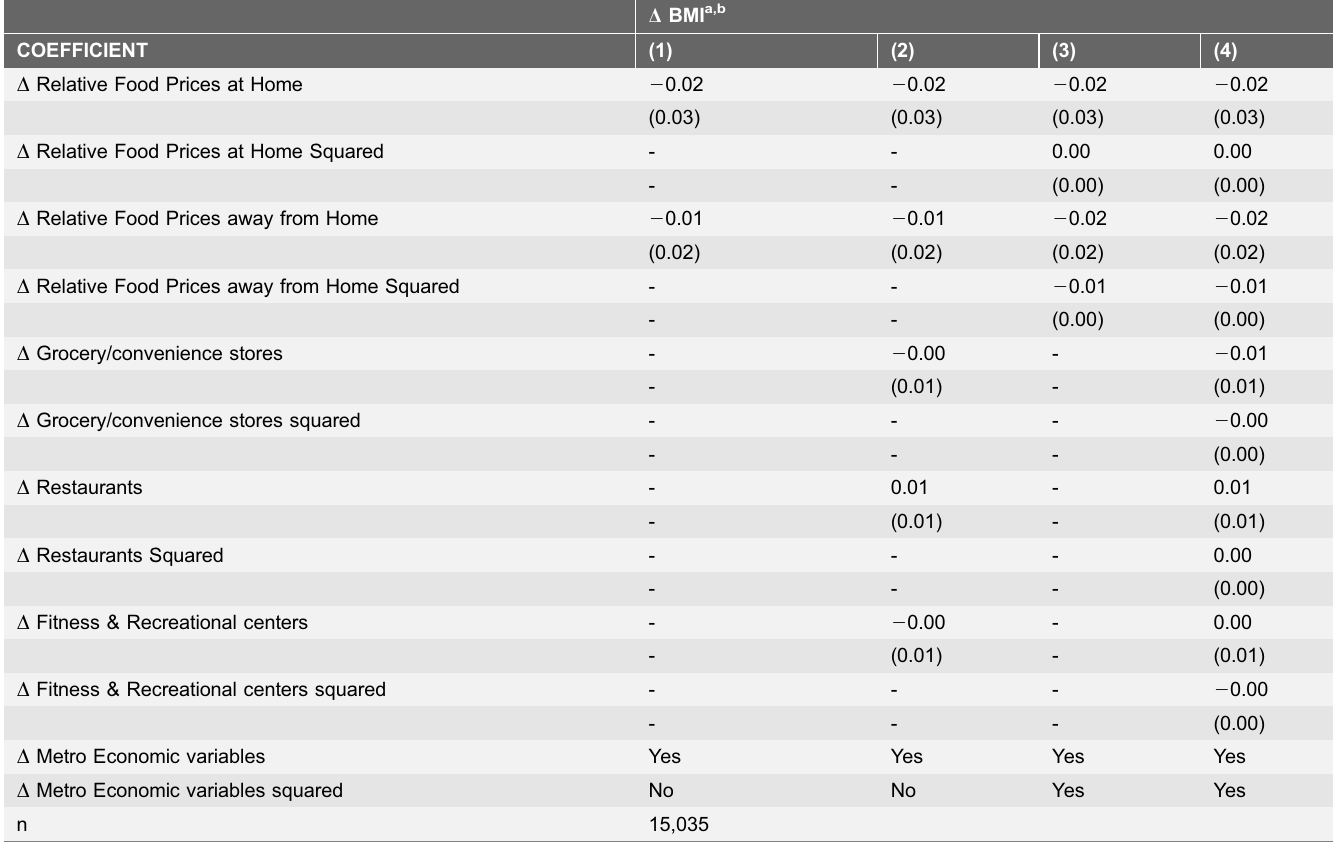
Table 2. The Estimated Effects of Relative Food Price Changes on